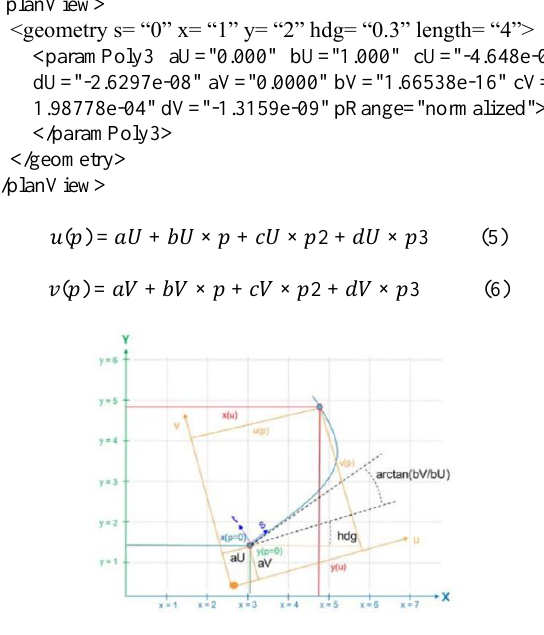
Figure 6. A sample of parametric cubic polynomial. (OpenDRIVE